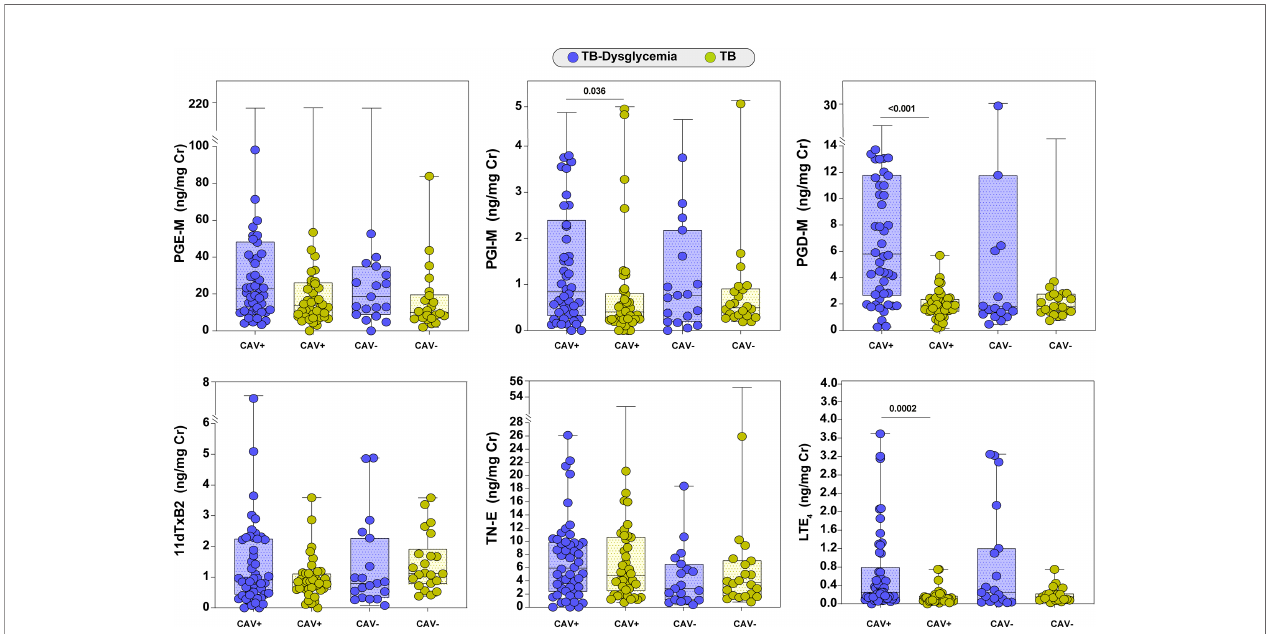
FIGURE 4 | Urinary eicosanoid levels and tuberculosis severity. Scatter plot depicting the distribution of eicosanoids (median and interquartile range) among TB- Dysglycemia and TB cases with cavitation (CAV+) and without cavitation (CAV-) at baseline. Groups were compared using Kruskal Wallis test. Only statistically signi fi cant differences are shown. PGE-M, major urinary PGE 2 metabolite; PGD-M, major urinary PGD 2 metabolite; PGI-M, 2,3-dinor-6-keto-PGF 1 a (PGI 2 Metabolite); 11dTxB2, 11-dehydro-thromboxane B